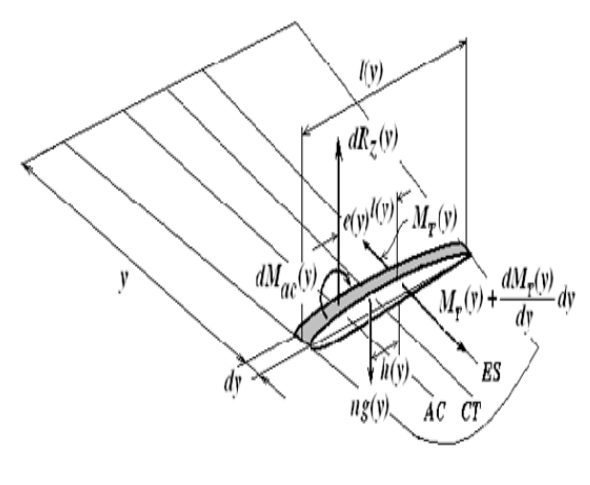
Figure 3. Torsional divergence